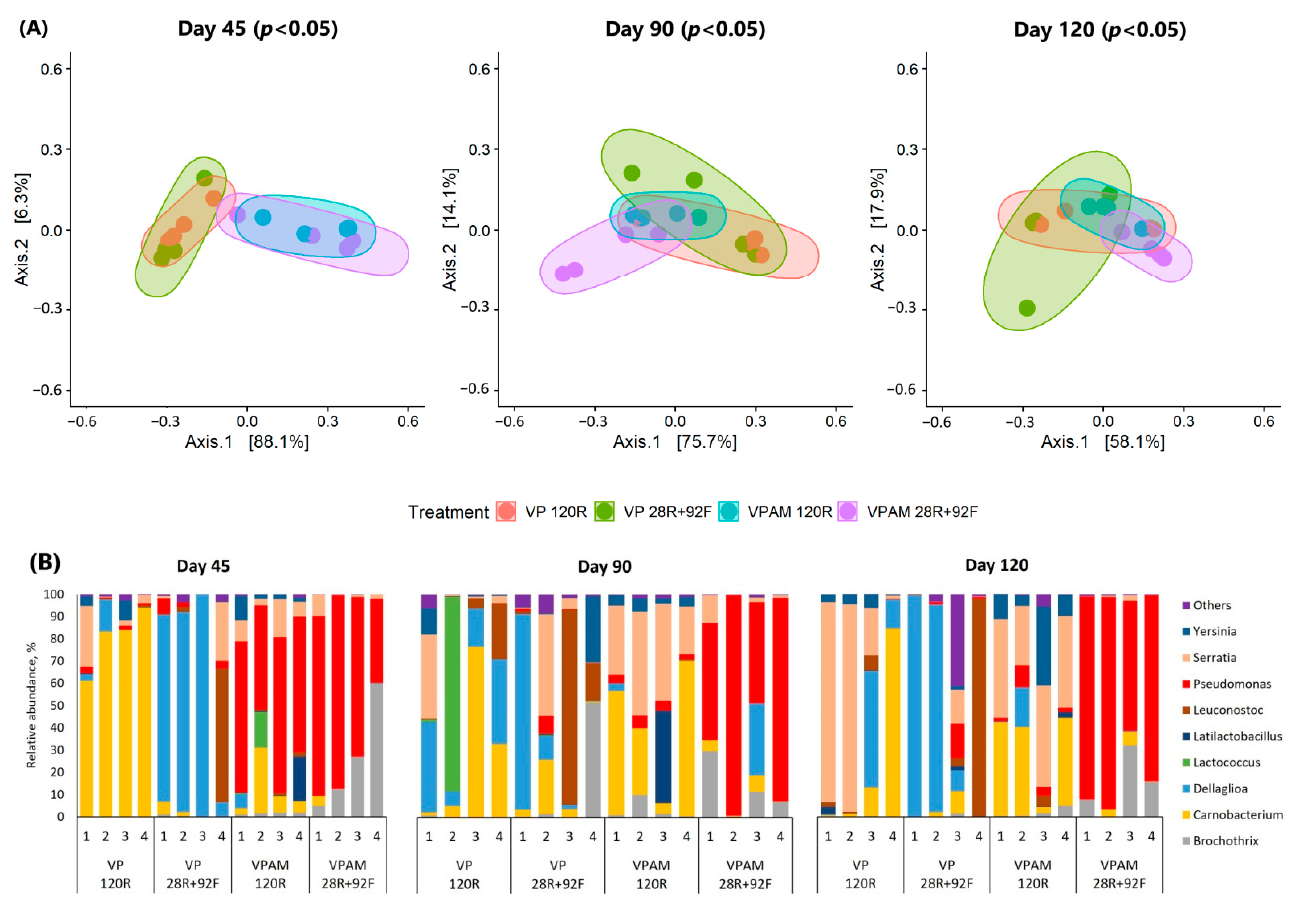
Figure 5. ( A ) The principal coordinate plot of beta diversity measured by weighted UniFrac distances at amplicon sequence variants (ASV) level on days 45, 90, and 120. ( B ) Relative abundance (%) of most predominant bacterial genera in individual meat samples for each treatment within each sampling time. Treatments: vacuum packaging for 120 days (refrigerated) (VP 120R), vacuum packaging for 28 days (refrigerated) + 92 days (frozen) (VP 28R+92F), vacuum packaging with antimicrobial for 120 days (refrigerated) (VPAM 120R), vacuum packaging with antimicrobial for 28 days (refrigerated) + 92 days (frozen) (VPAM 28R+92F). On day 90, Leuconostoc ( p < 0.05) was enriched in VP samples. In addition, PSE was